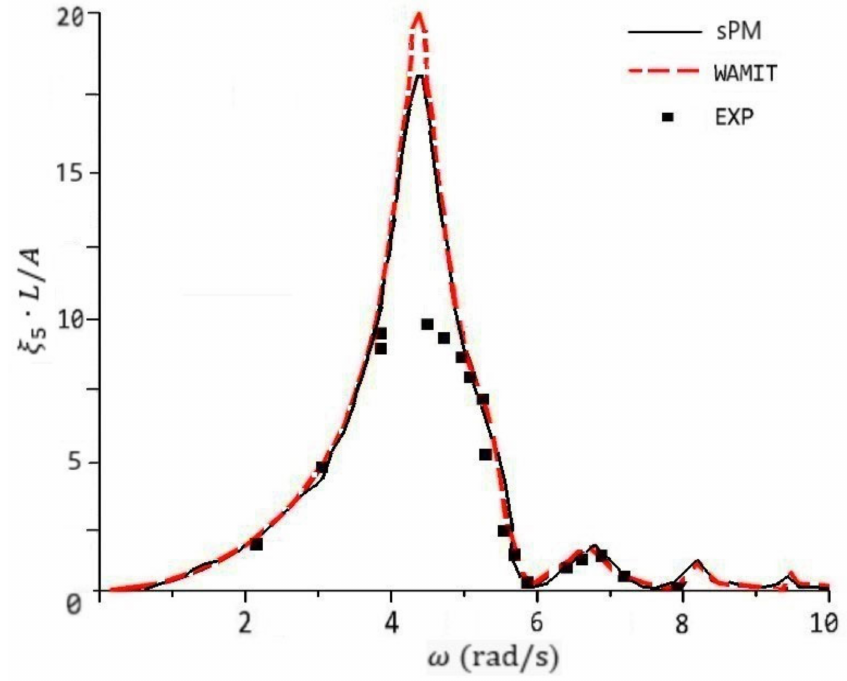
Figure 6. Pitch RAO obtained by the sPM as compared with WAMIT results [23] and experimental data